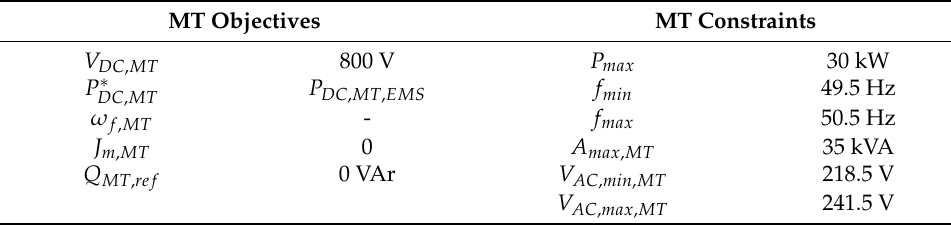
Table 5. MT Controller parameters. PQ mode.